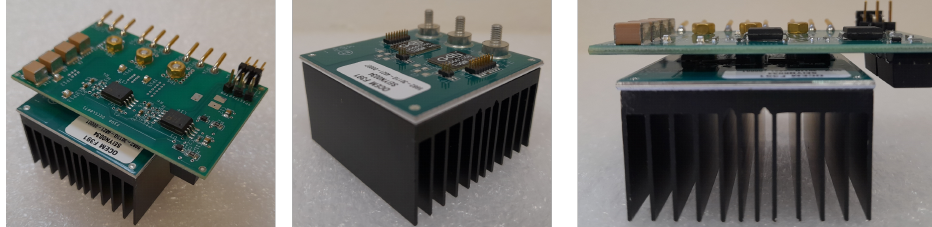
Figure 14. GaN IMS board and driver board.